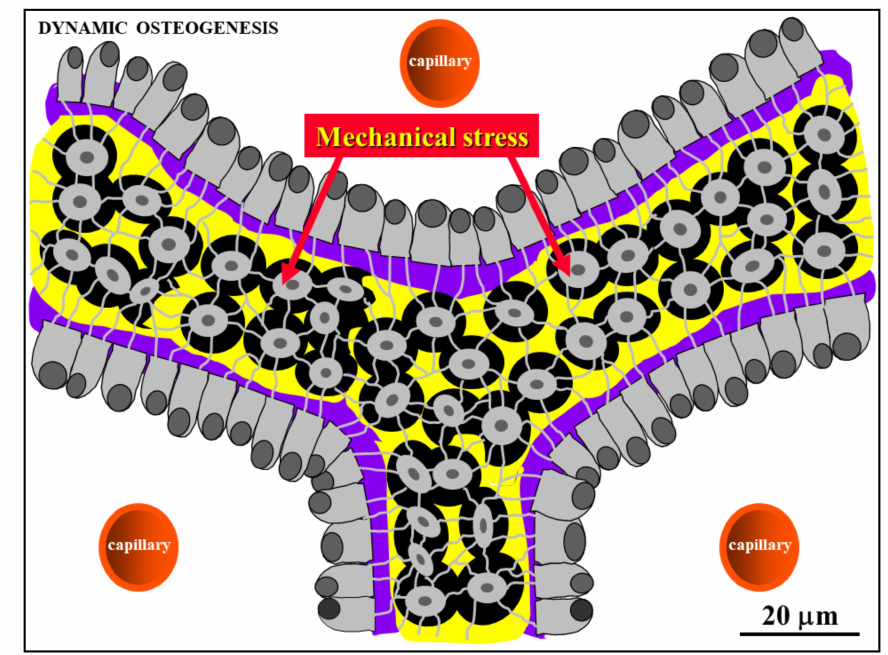
Figure 7. Schematic drawing showing laminae of movable osteoblasts laying down bone matrix (purple) on the surfaces of SO trabeculae (see text for further